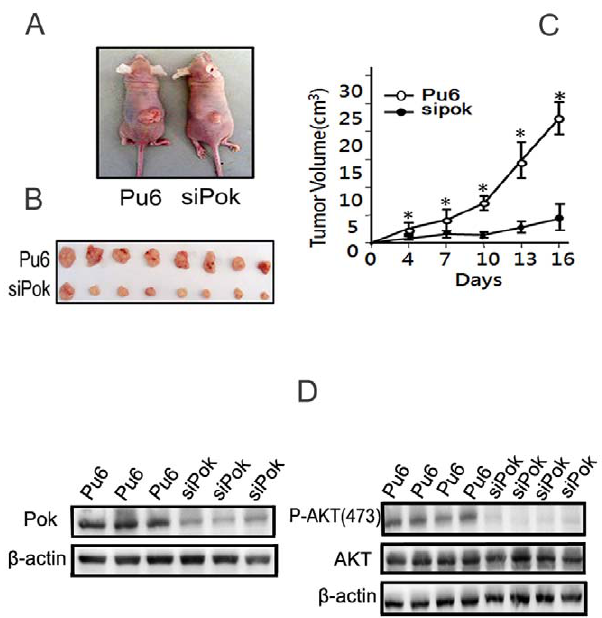
Figure 5. Pokemon silencing inhibits the proliferation of HepG2 cells in vivo. Nude mice were subcutaneously injected with HepG2-siPokemon or HepG2-Pu6 cells, and the tumors were excised after 16 days. ( A, B ). Representative images of tumors in nude mice. ( C ). The tumor volumes were recorded every three days for 16 days. The figure shows the mean 6 SD (8 mice per group, * P , 0.01). ( D ). Confirmation that Pokemon knockdown and decreased P-Akt levels are maintained in